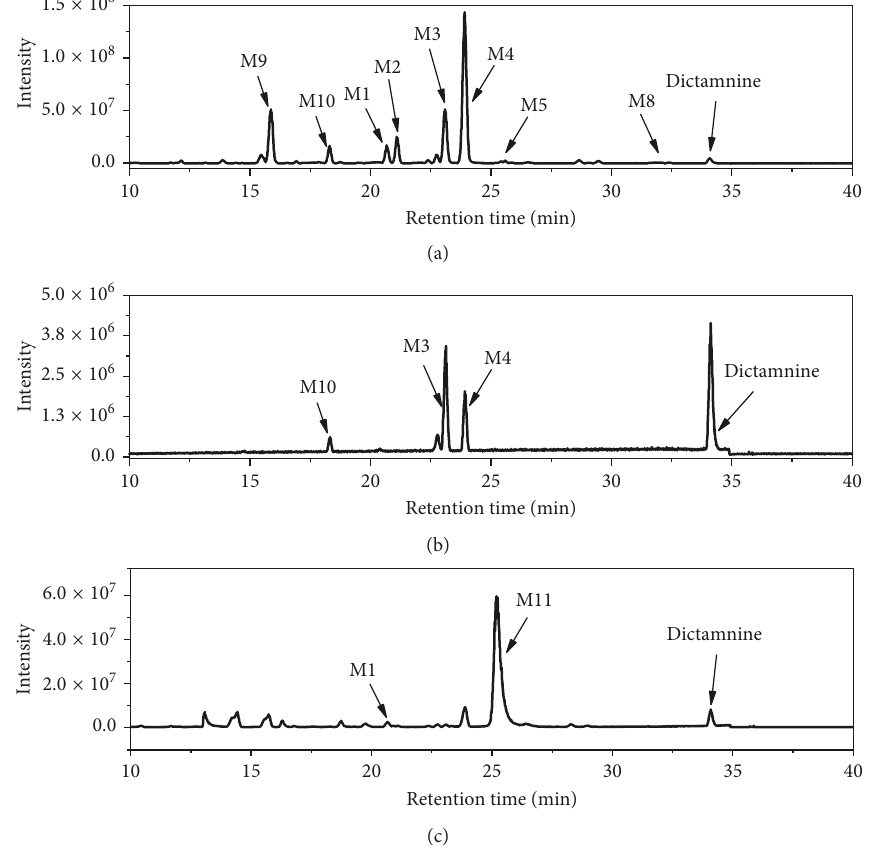
Figure 1: Extracted ion chromatograms of dictamnine and its metabolites in mouse urine (a), plasma (b), and feces